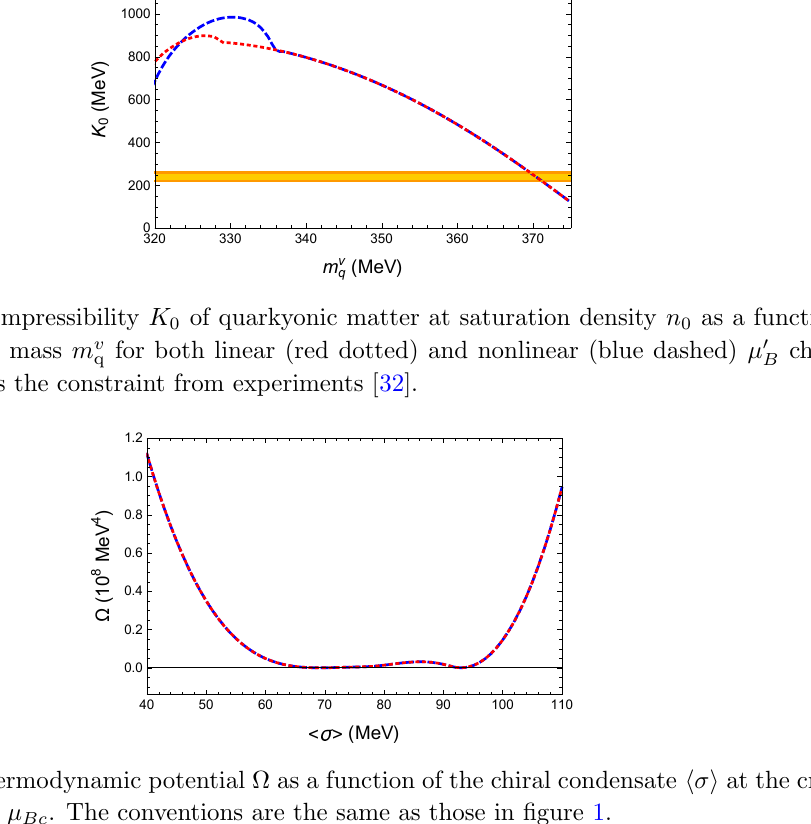
Figure 3 . The thermodynamic potential (cid:10) as a function of the chiral condensate h (cid:27) i at the critical chemical potential (cid:22) Bc . The conventions are the same as those in (cid:12)gure